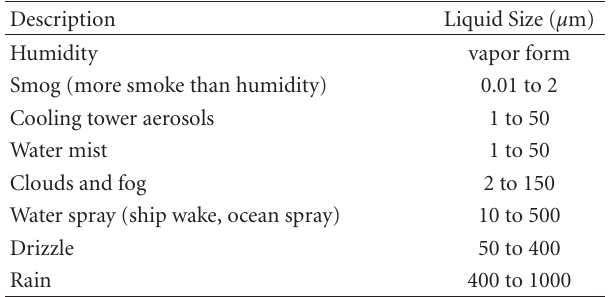
Table 2: Di ff erent types of moisture experience in inlet filtration systems [2, 23].